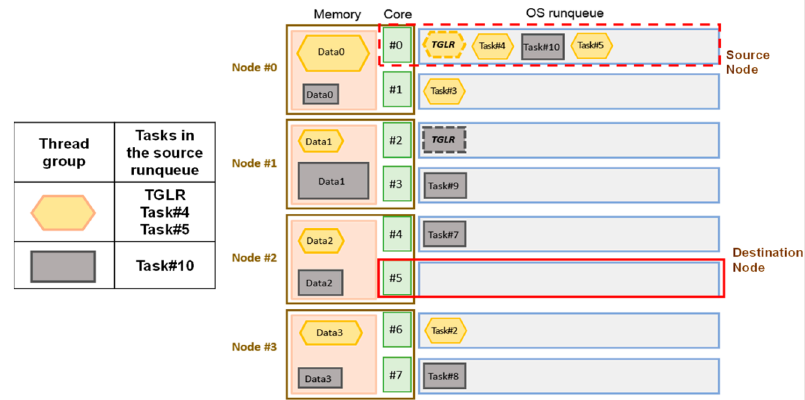
Figure 9. Two thread groups with different levels of exclusivity.